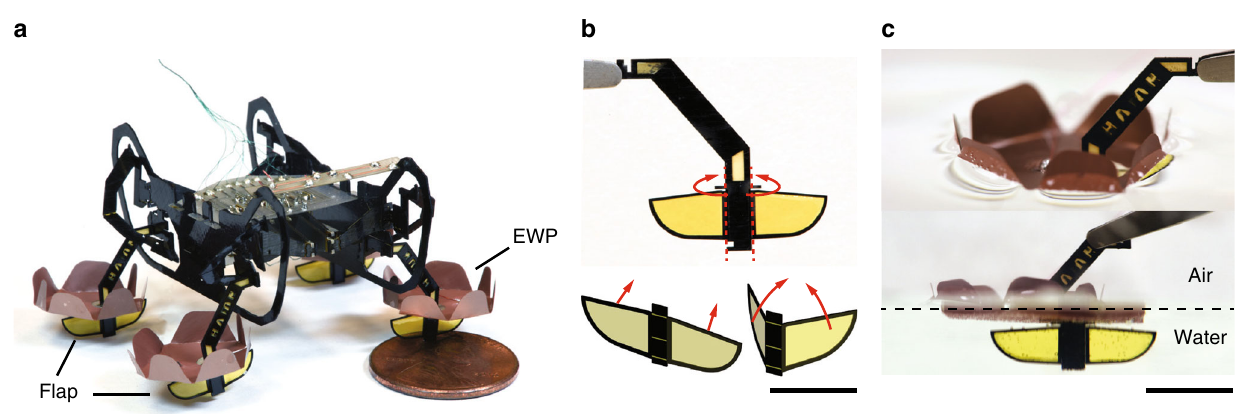
Fig. 1 Design of a hybrid terrestrial-aquatic microrobot and its electrowetting pads. a A quadrupedal, 1.6 g, 4 cm × 2 cm × 2 cm hybrid terrestrial-aquatic microrbot. The robot is powered by eight piezoelectric actuators and each leg has two independent degrees-of-freedom. Each robot leg consists of an electrowetting pad (EWP) and two passive fl aps. b Two passive fl aps are connected to the central rigid support via compliant polyimide fl exures. These passive fl aps retract under drag forces opposing the robot ’ s heading but remain open under thrust forces in the same direction as the robot ’ s heading. c Perspective and front views of an EWP on the water surface. The EWP supports the robot weight via surface tension effects and the fl aps paddle underwater to generate thrust forces. Scale bars ( b – c ), 5